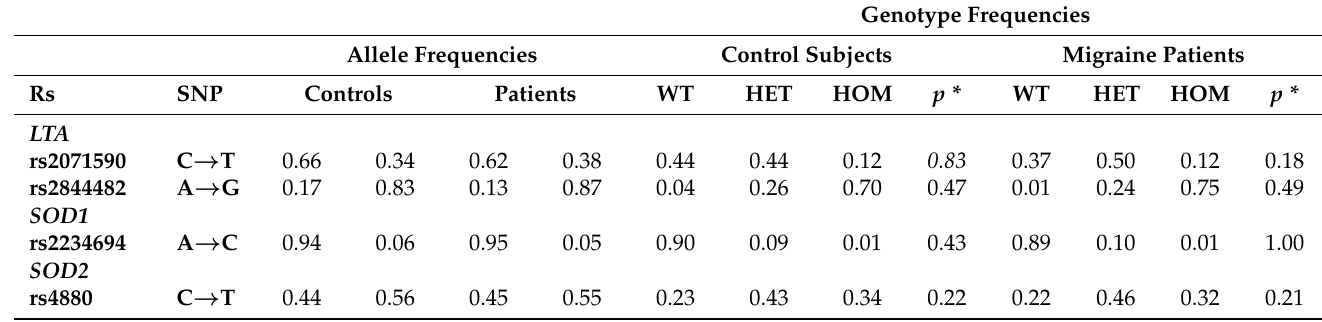
Table 2. Lymphotoxin alpha ( LTA ) and superoxide dismutase 1 ( SOD1 ) and 2 ( SOD2 ) genetic polymor- phisms and corresponding allele frequencies in 370 migraine patients and 100 control